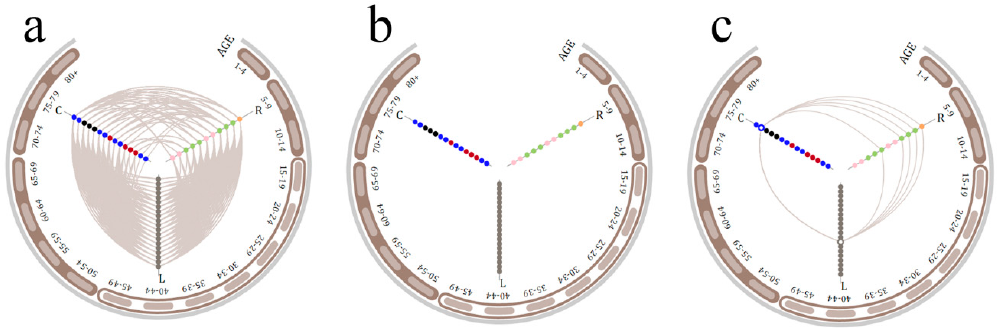
Figure 5. ( a ) Visualization with all the relationships shown; ( b ) default configuration used in our visualization with no relationships shown; ( c ) state of the visualization when the user has selected specific relationships to explore.